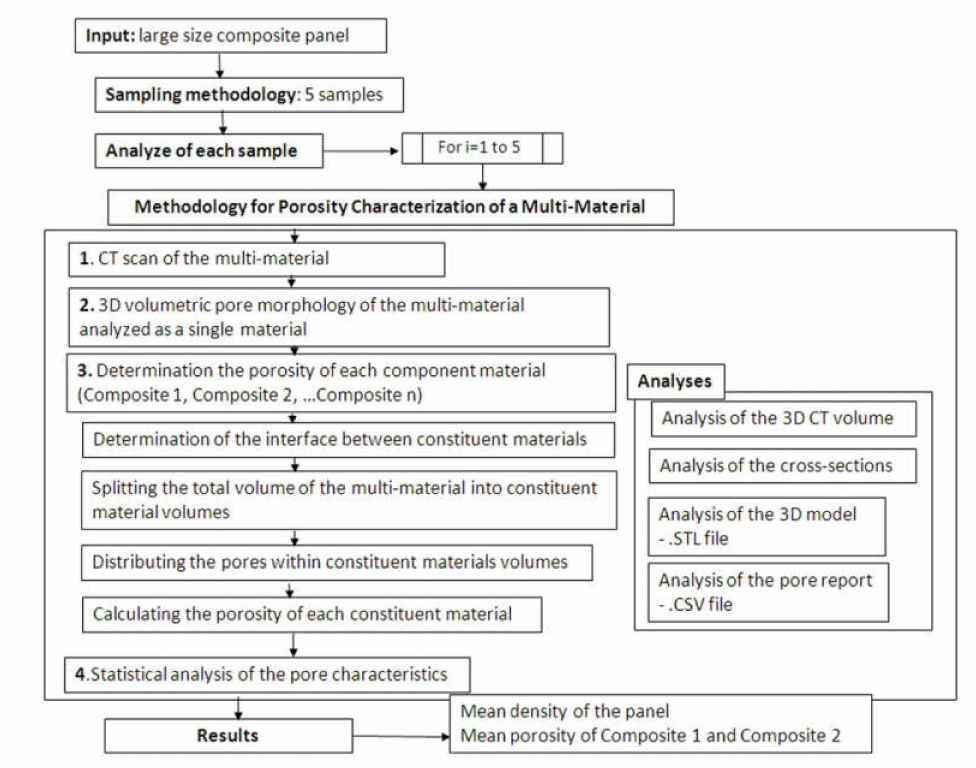
Figure 5. Methodology for porosity and density analysis of a multi-material